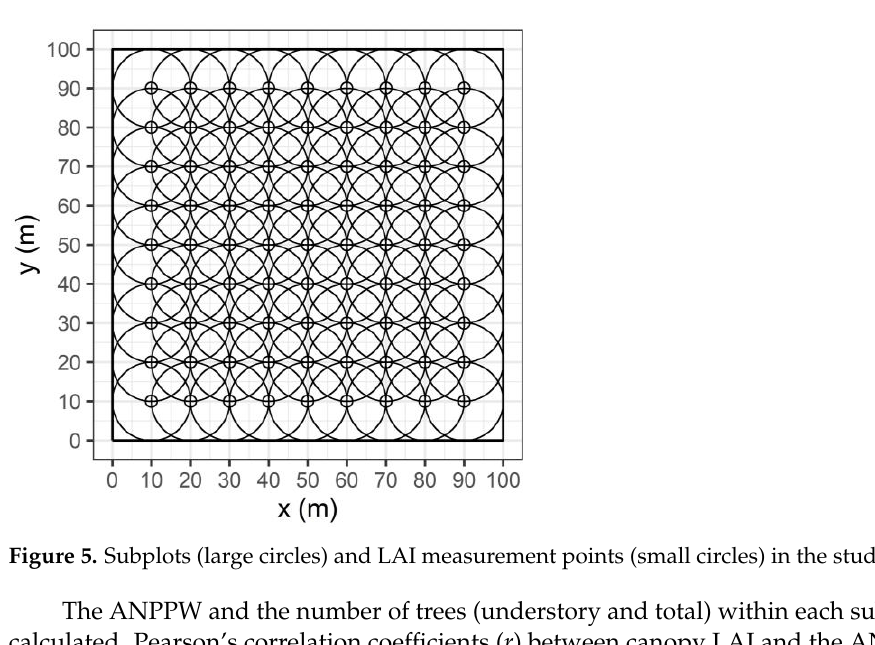
Figure 4. Semivariogram of LAI. The horizontal axis is the distance between the measurement points, and the vertical axis is the semivariance. A high semivariance indicates a weak correlation between data points collected at that distance.